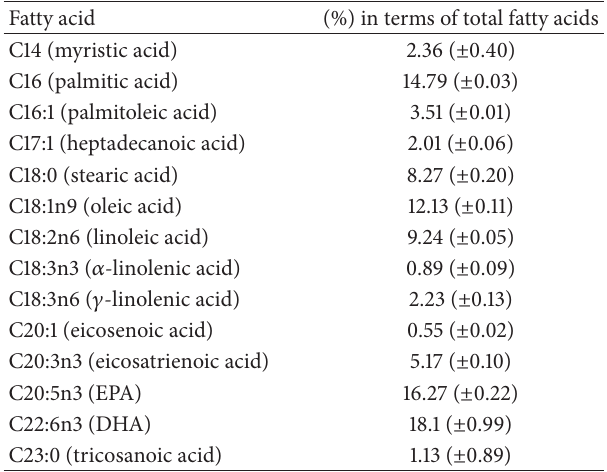
Table 1: Fatty acids from liver oil of Echinorhinus brucus . Data expressed as a percentage of wet weight. Value represents the mean ±